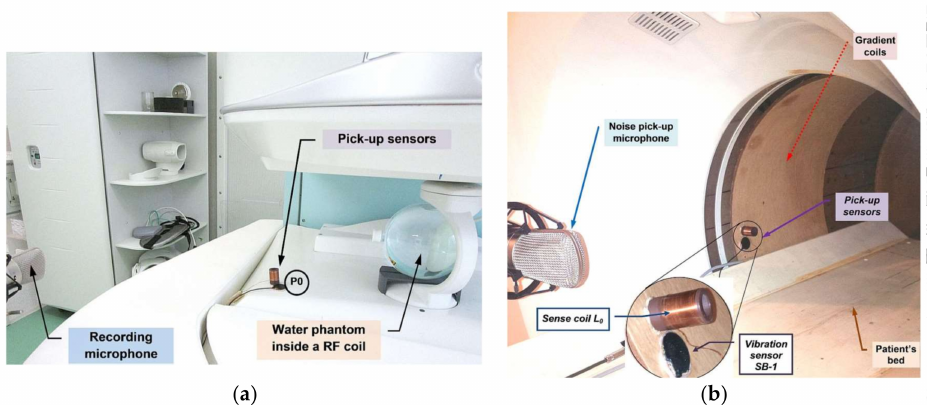
Figure 1. Photo of sensors placement for recording of vibration, noise, and electrical excitation signals in open-air and whole-body devices; ( a ) E-scan Esaote Opera with the spherical water phantom inside the knee RF coil; ( b ) MR imager